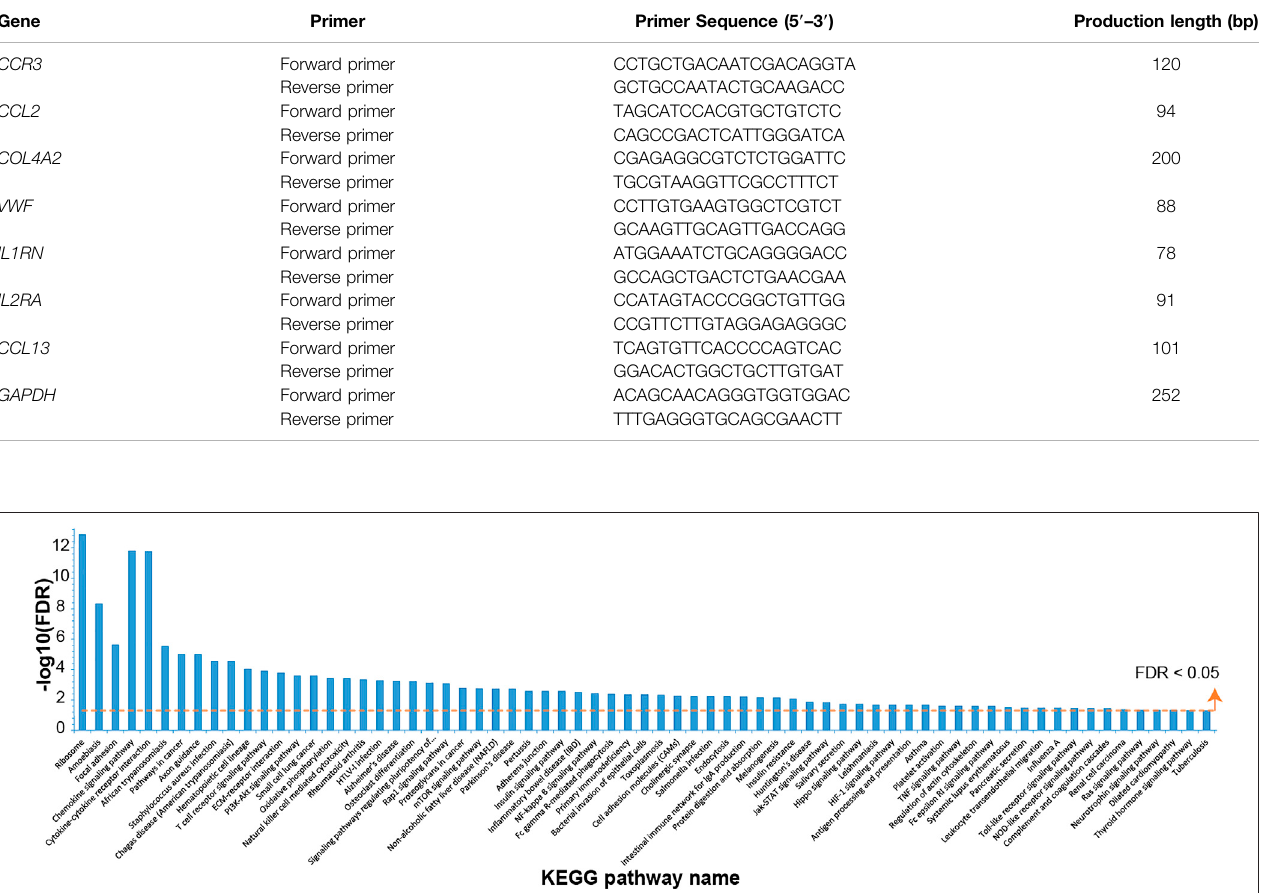
Frontiers in Genetics |